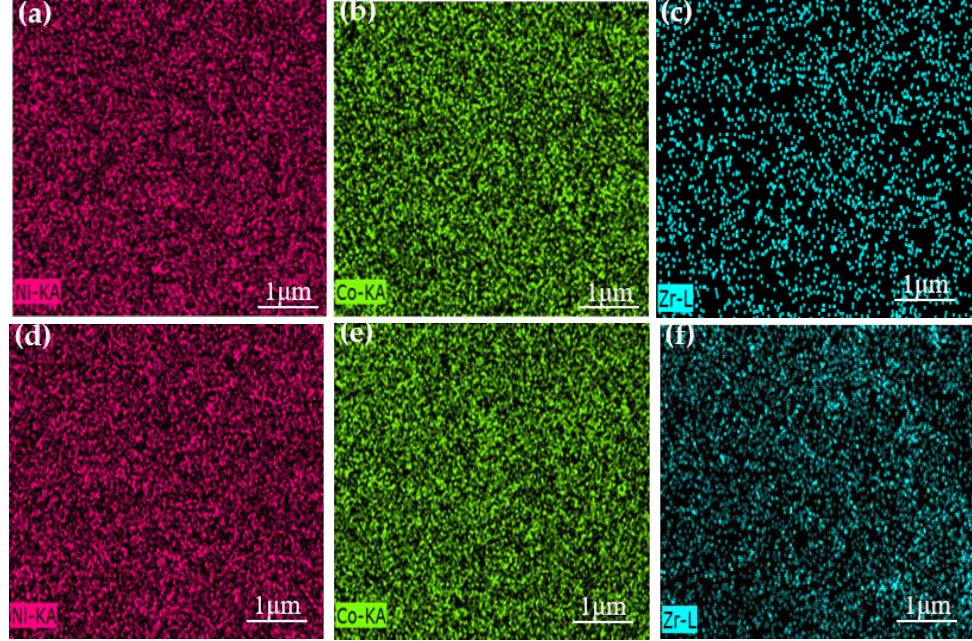
Table 3. Mass fraction of elements in alloy coated samples prepared under different conditions.